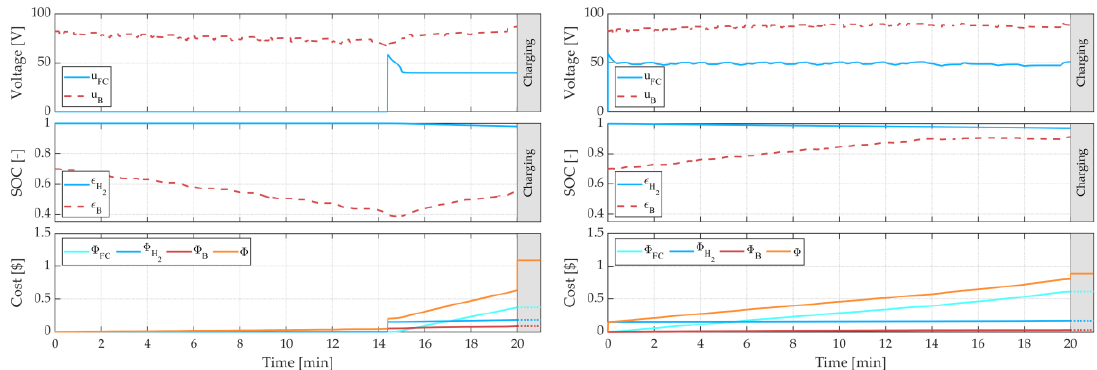
Figure 16. Voltages, state-of-charge and costs achieved over NEDC by H-EMS ( left ) and S-EMS ( right ).